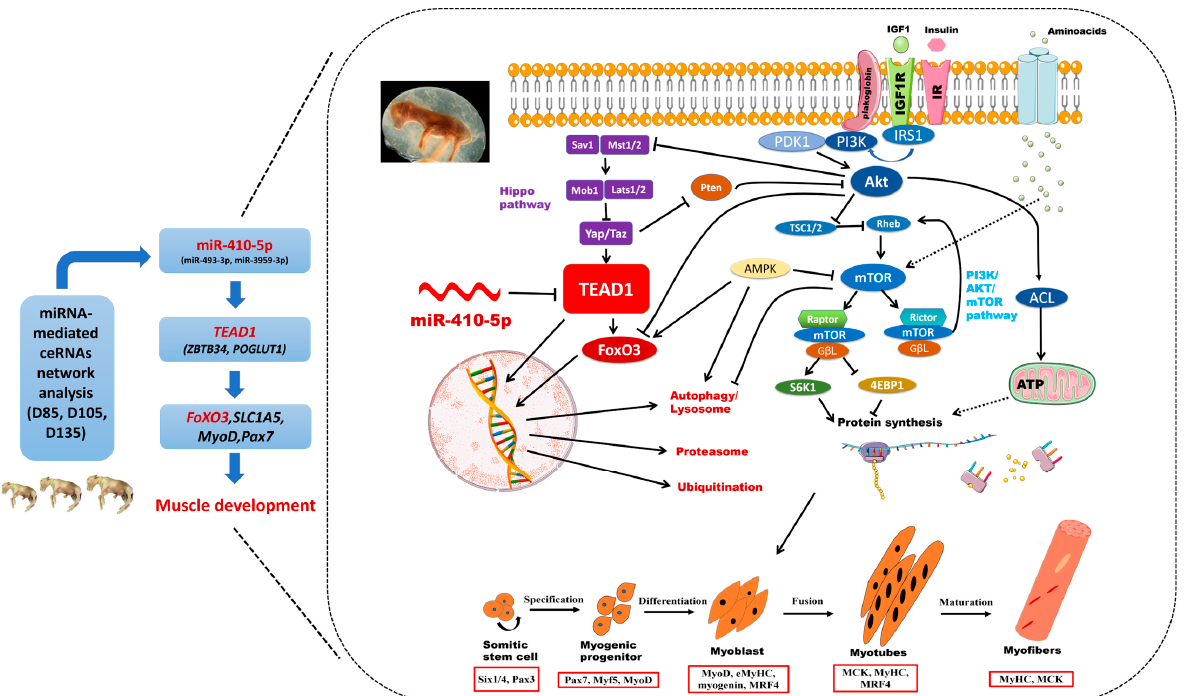
Figure 8. The molecular mechanism of the TEAD1 gene and miR-410-5p affecting embryonic skeletal muscle development through a miRNA-mediated ceRNA network analysis.